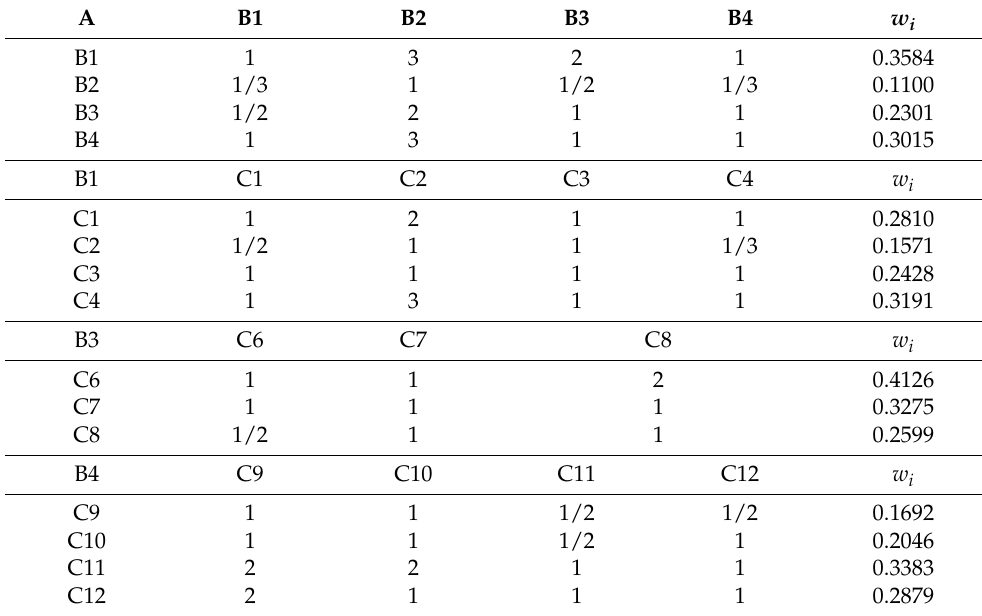
Table 2. Judgement matrix of indicator layer A and indicator layer B.